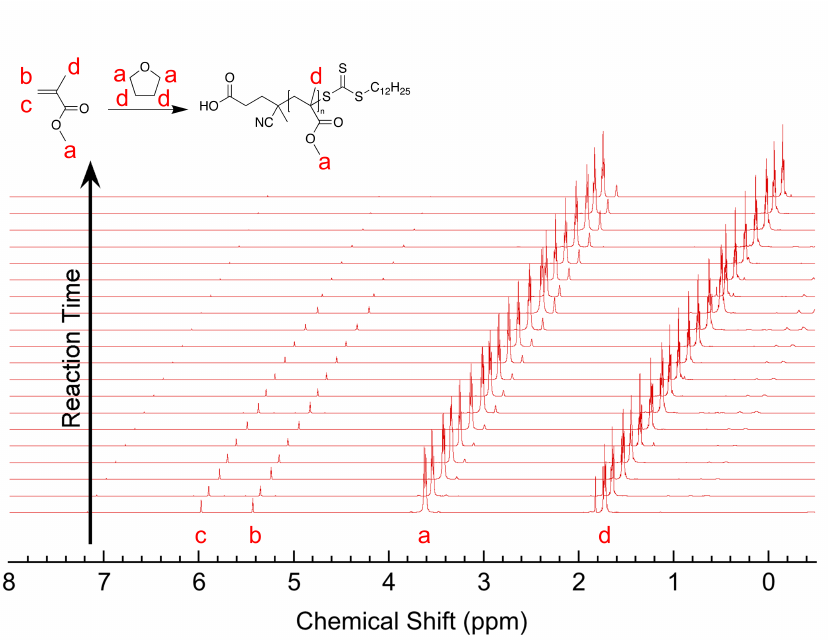
Figure 3. 1 H NMR spectra of PMMA-1 vs. time (scaled to reference band a).